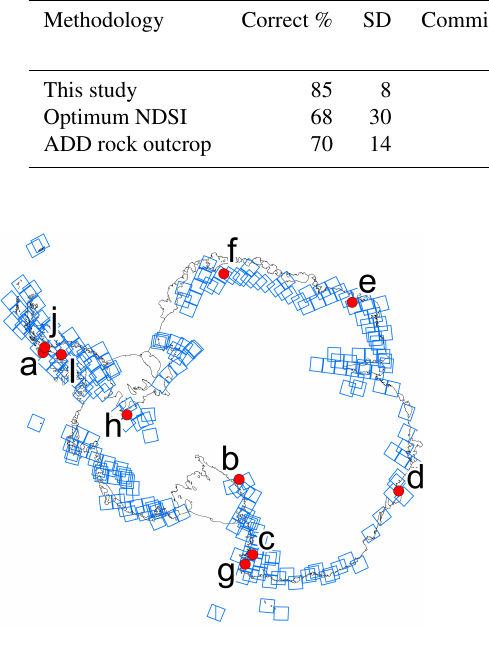
Figure 9. Locations of the 249 Landsat 8 tiles (blue squares) used to identify rock outcrop in Antarctica and the locations (a–j) of the 10 × 10km images used for the quality assessment in Fig. 8.